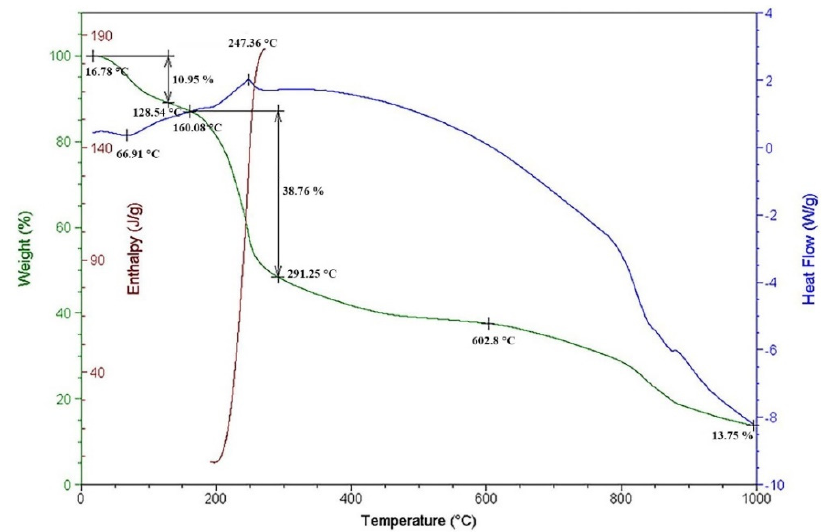
Figure 5. Thermogravimetry and differential scanning calorimetry curves for the sodium pectate complex with copper.